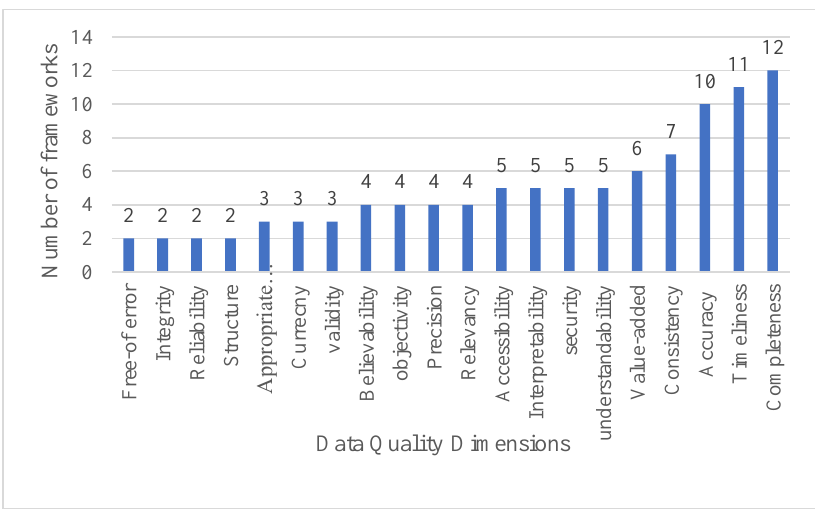
Figure 1. Number of frameworks that used specific data quality dimensions.